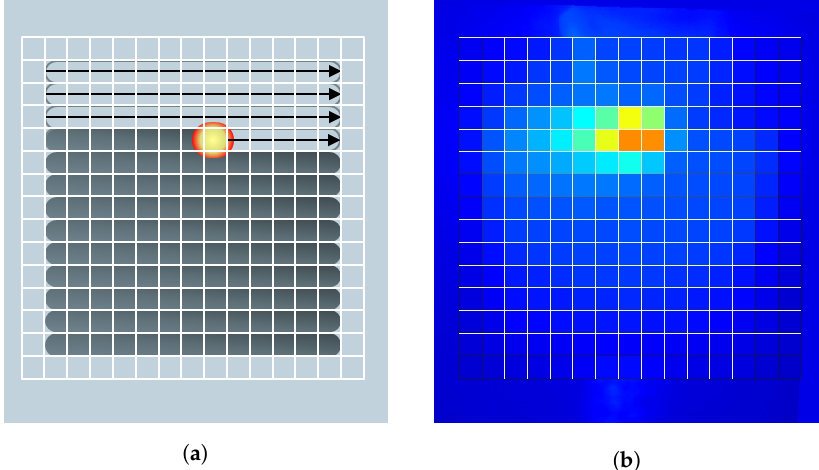
Figure 10. Illustration of spatial discretization for one layer: ( a ) Schematic of specimen with grid, ( b ) corresponding false color image with